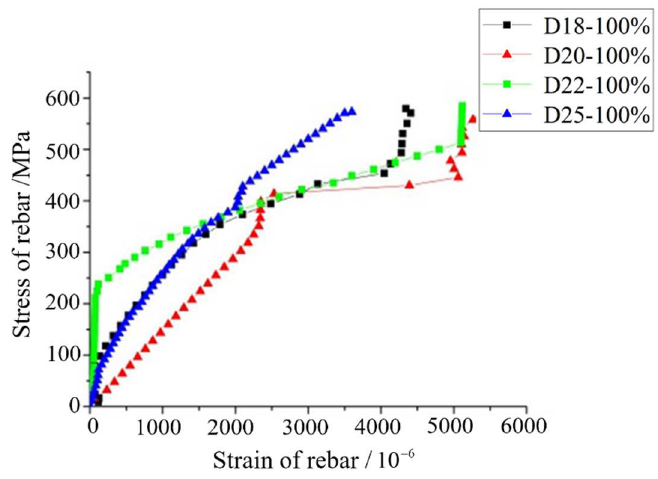
Figure 10. Rebar stress-strain curves for fully compact connectors.